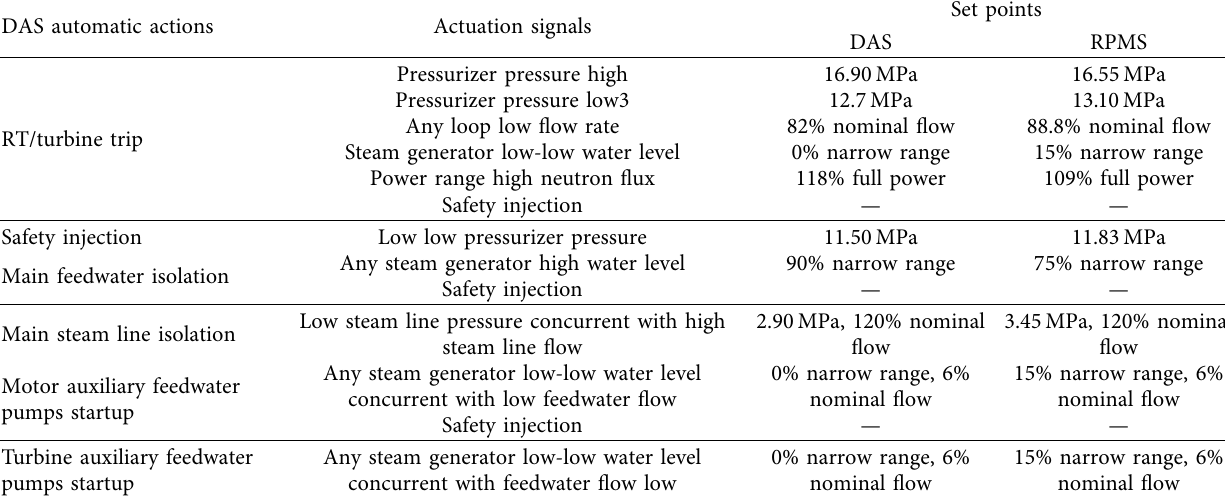
Table 2: Automatic actions and set points on DAS.